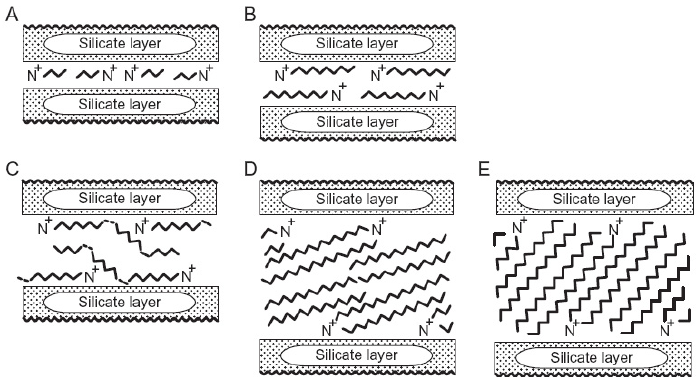
Figure 2. Arrangement of alkylammonium ions in the interlayer space of smectites: ( A ) monolayers, ( B ) bilayers, ( C ) pseudo-trimolecular layers, ( D , E ) paraffin type arrangements with different tilting angles of the alkyl chains [18].